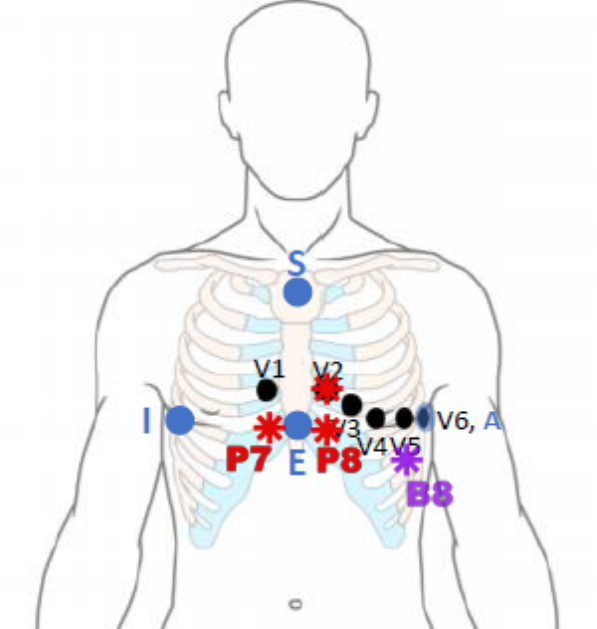
Figure 6. Additional electrodes location. In blue dots, the Dower location, and in red and purple, our proposed location. Red dots ( V 2, P 7 and P 8) are located in the patient’s chest, and the purple one ( B 8) is placed in the back. In black, the standard precordial leads are shown for